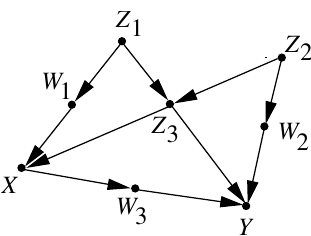
Figure 1: A graphical representation of Model 1. Error terms are assumed mutually independent and not shown explicitly.